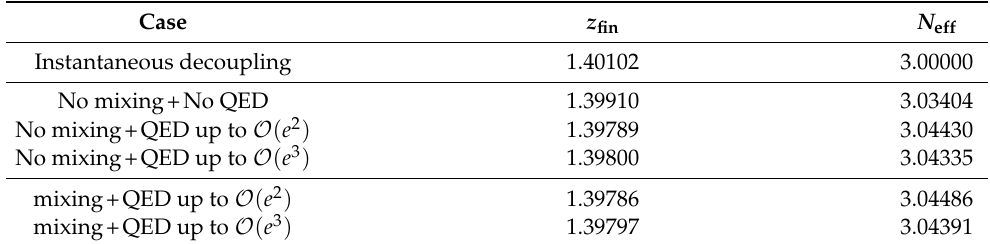
Table 2. Final values of comoving photon temperature and the effective number of neutrinos for flavor neutrinos in several